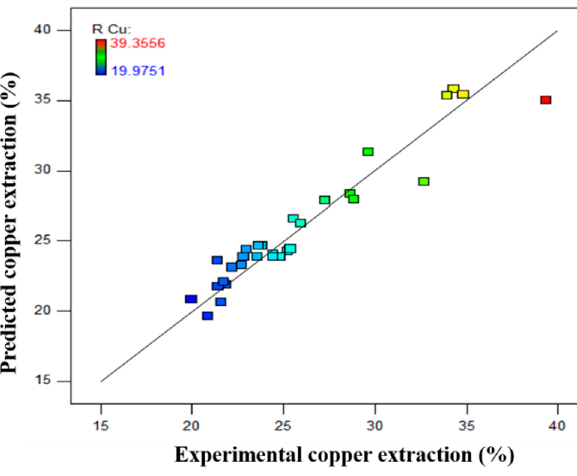
Figure 4. Predicted vs. actual plots for copper recovery.